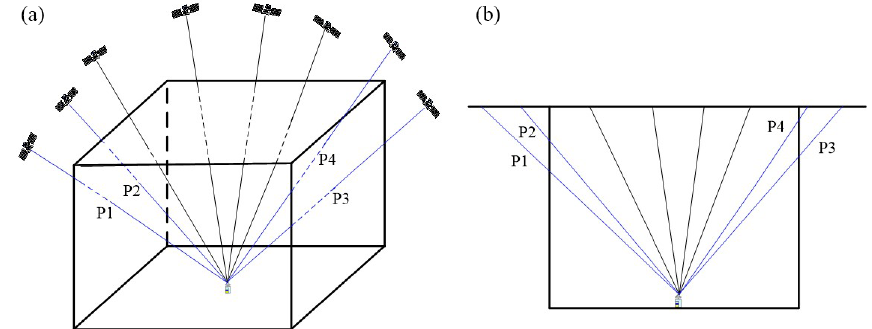
Figure 1. Schematic diagram of satellite signals crossing the tomography area (a) and their front view (b) , where signals P1–P4 are crossed from the side of the tomography